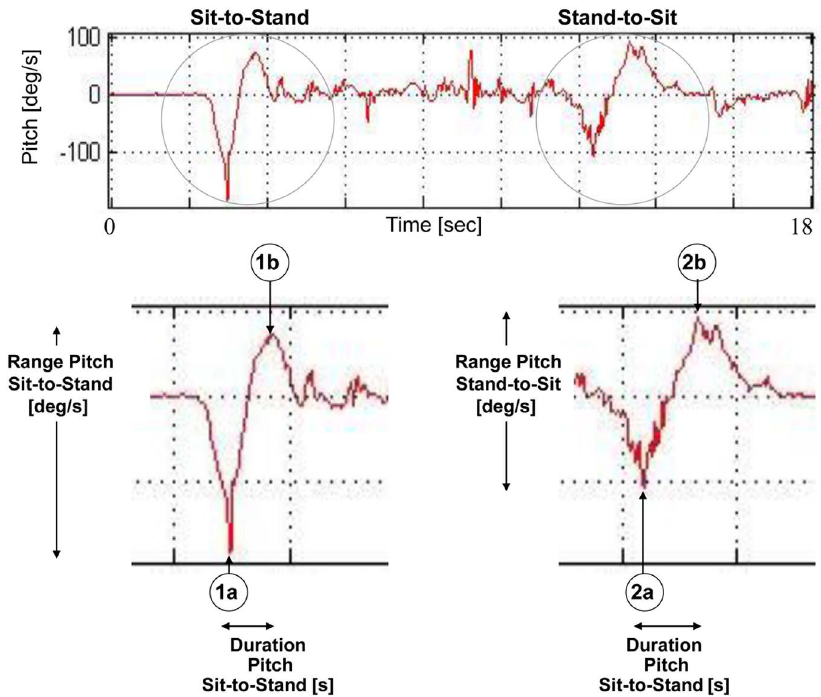
Figure 2. Transition measures from the pitch axis. Transition components derived from the pitch axis. The upper figure shows the TUG pitch signal, where transition 1 (sit-to-stand) and transition 2 (stand-to-sit) components are evident as ‘‘tilted S’’ shaped objects. The lower figure shows a close-up of pitch transitions, with 1a and 1b as the minimum and maximum points of transition 1 (respectively), and 2a and 2b as the minimum and maximum points of transition 2, respectively. The pitch range [deg/s] and the transition duration [s] measures are depicted. The jerk, which is not shown here, is simply the slope of the pitch signal between the minimum and maximum points.